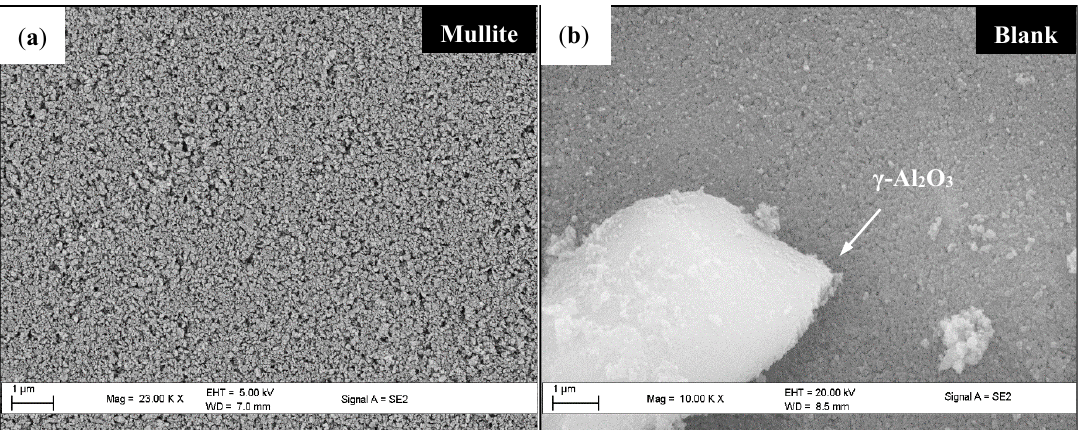
Figure 16. SEM micrographs of catalysts; ( a ) uncoated mullite (no γ -Al 2 O 3 and Co), ( b ) blank catalyst.